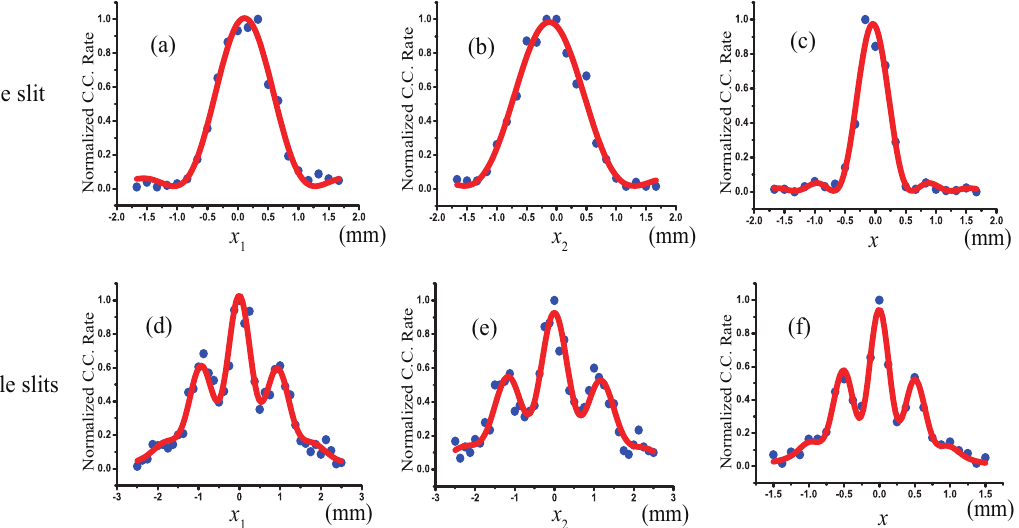
Figure 2. The experimental measurements of interference-diffraction patterns. The three figures in the first row are the experimental results of the diffraction of a single slit. The three figures in the second row show the interference-diffraction patterns of a double slits. In the first column ( a , d ), detector D 2 is fixed and detector D 1 is scanned in plane X 1 . In the second column ( b , e ), detector D 1 is fixed and detector D 2 is scanned in plane X 2 . In the third column ( c , f ), two detectors are scanned synchronously in planes X 1 and X 2 , respectively. According to Klyshko’s picture, what we measured in the first two columns is the non-degenerate ghost interference/diffraction. The results in the third column are the measurements of the non-degenerate quantum lithography of a single slit ( c ) and a double slit ( f ),